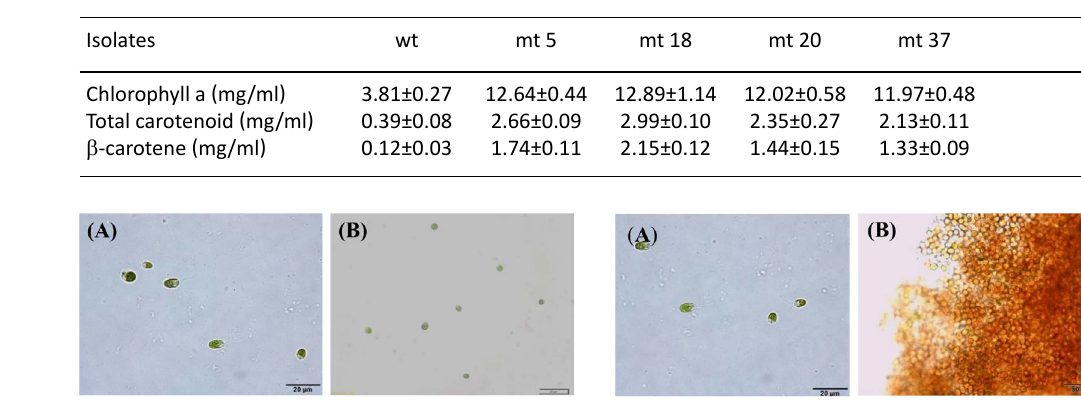
Table 1. Chlorophyll a, Total carotenoid and β -carotene content in the mutants (mt) 5,18,20 and 37 at the 12 th day of cultivation, wild type (wt)